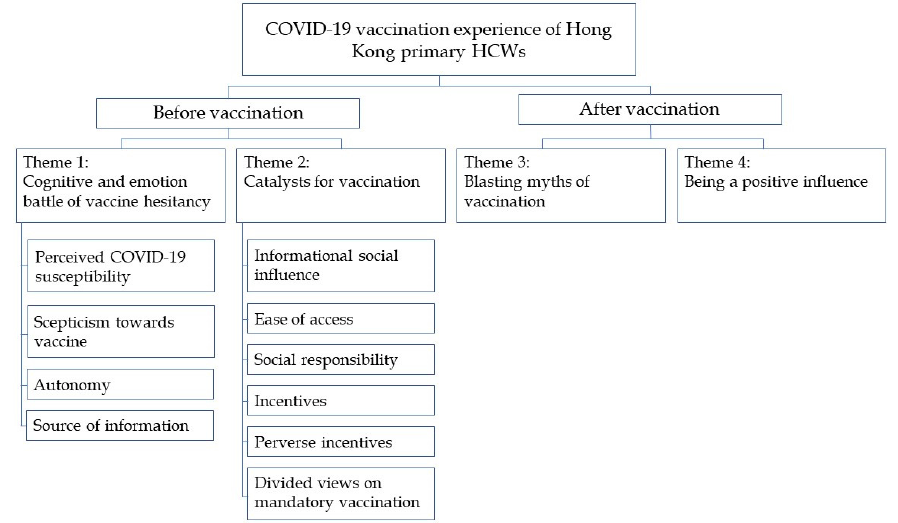
Figure 1. Themes and subthemes of the study.